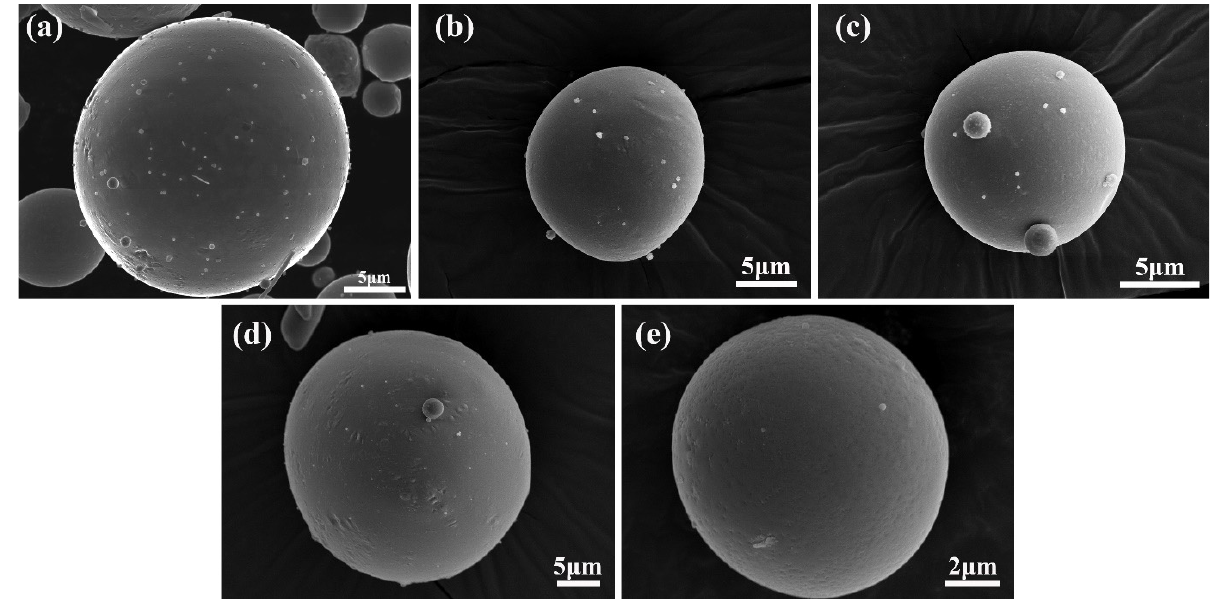
Figure 1. ( a ) SEM images of raw amorphous powder, ( b ) phosphated amorphous powder, ( c ), ( d ) and ( e ) the phosphated powder after annealing at 440 °C, 440 °C and 520 °C, respectively.